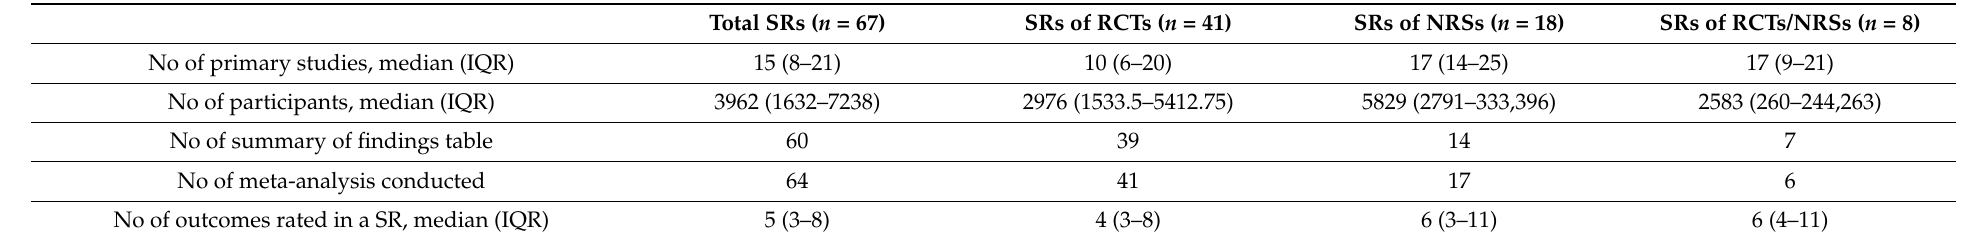
Table 5. Summary of the systematic review